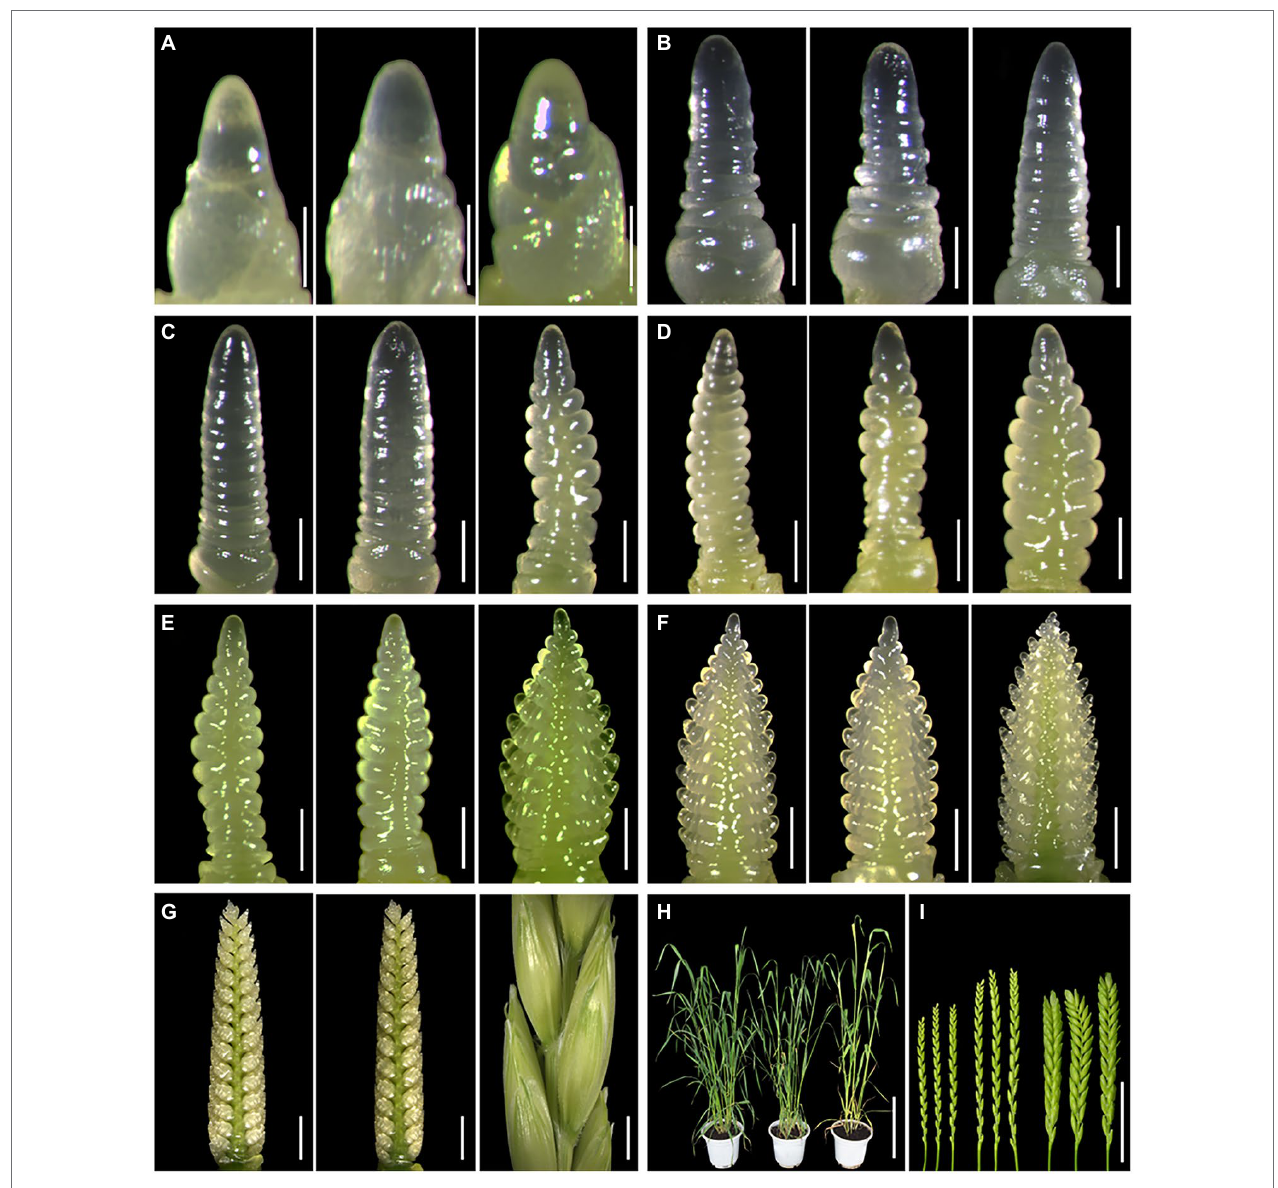
FIGURE 4 | Morphological observation of spike differentiation in different dates under field conditions. Different uppercase letters indicate the date of observation. (A) November 17, 2020. (B) December 15, 2020. (C) December 30, 2020. (D) January 12, 2021. (E) January 20, 2021. (F) February 2, 2021. (G) February 24, 2021. (H,I) March 10, 2021. Images of each panel from left to right are CS, CS ph2b and DT23, respectively. Scale bars: A, 200 μ m; B-F, 150 μ m; G, 50 μ m; H, 2 cm; I, 1 cm.